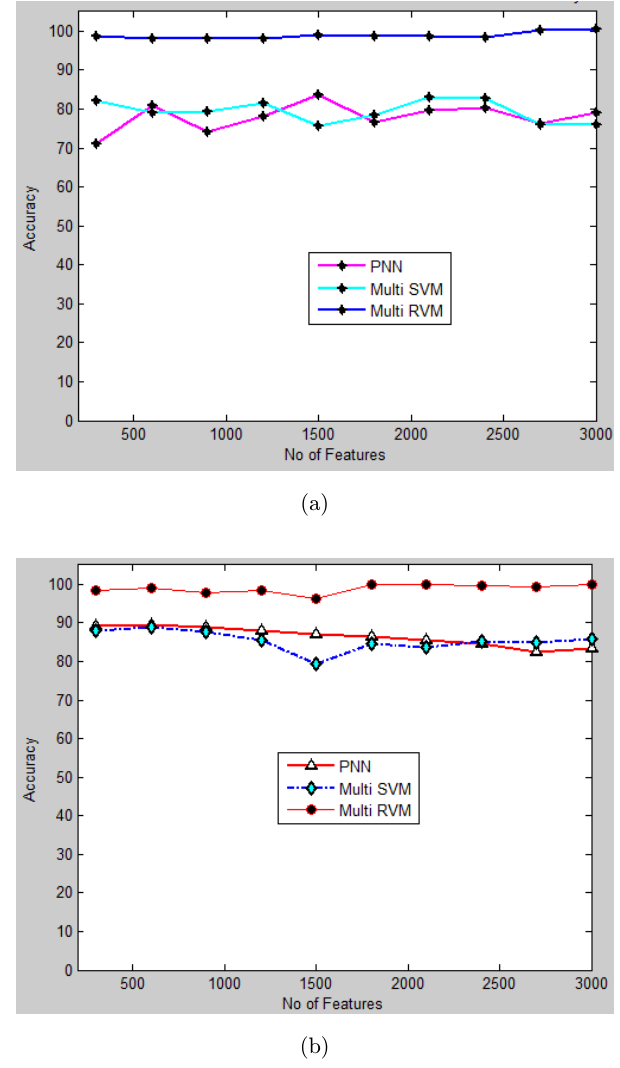
Fig. 11. (a) and (b) Accuracy analysis of M-RVM, PNN and Multi-SVM